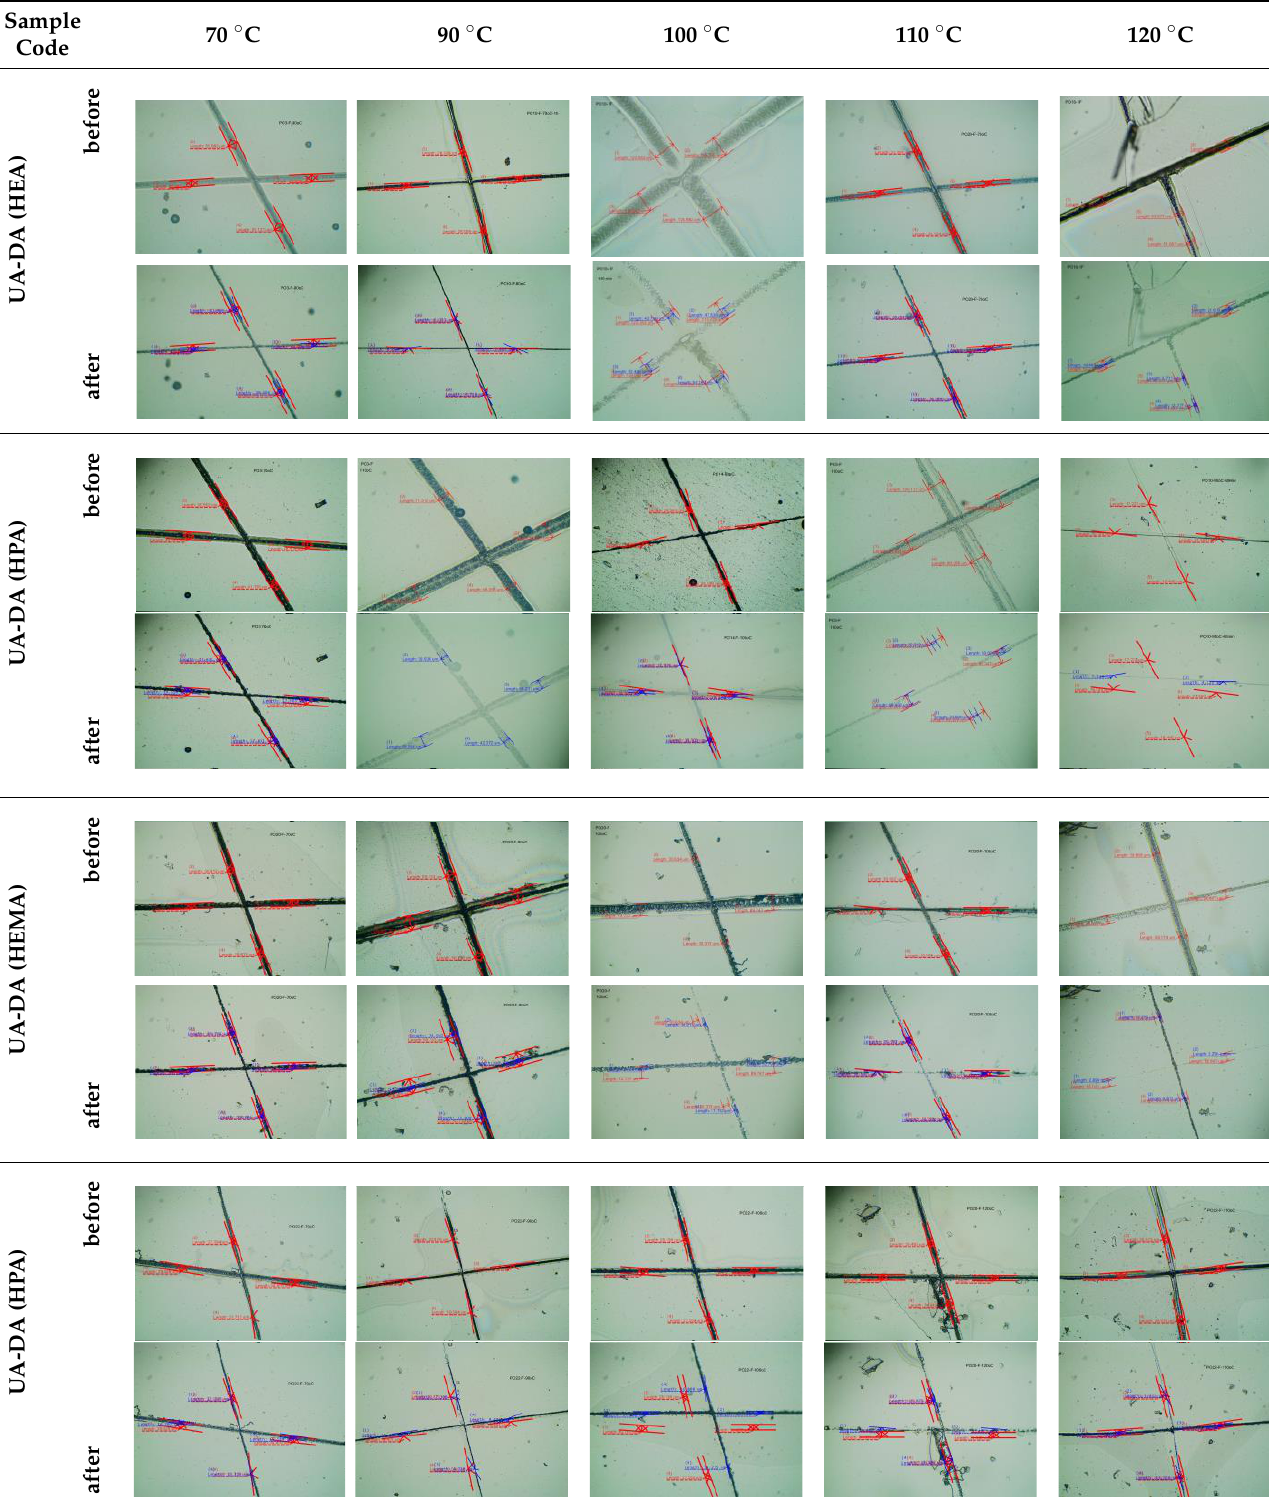
Figure 14. Self-healing properties based on microscopic images of UA-DA films heated at different temperatures. Table 5. Optical microscopy images of self-healing properties of coatings with scratches on the UA- DA films heated at different temperatures.